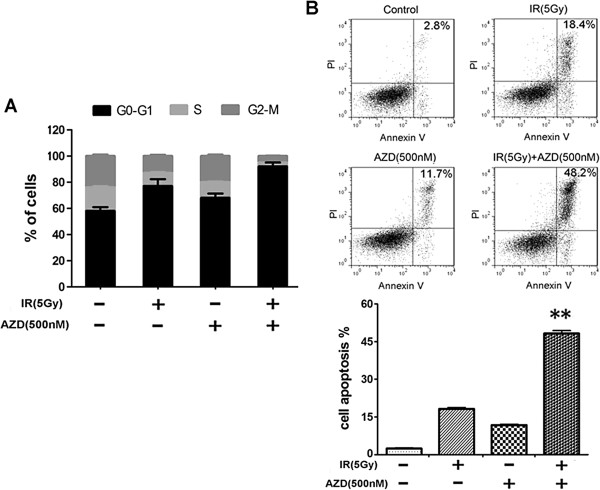
Blockade of radiation-induced mTOR phosphorylation by AZD8055 enhances radiation induced cell cycle arrest and apoptosis. (A) PANC-1 cells were treated with radiation (5 Gy) in the absence or presence of AZD8055 (500 nM) for 24 h, followed by analysis of cell cycle by flow cytometry. The cells in G0/G1, S and G2/M phases were presented in the percentage. The experiment was repeated three times and the percentages of cells in G0/G1 and S phases were presented as mean ± SD. (B) Annexin-V/PI cell apoptosis analysis of PANC-1 cells treated with radiation in the absence or presence of AZD8055 for 24 h, flow cytometry data showed the percentage of apoptotic cells The experiment was repeated three times and the percentage of apoptotic cells was presented as mean ± SD. **, P < 0.01 vs. IR treatment alone.